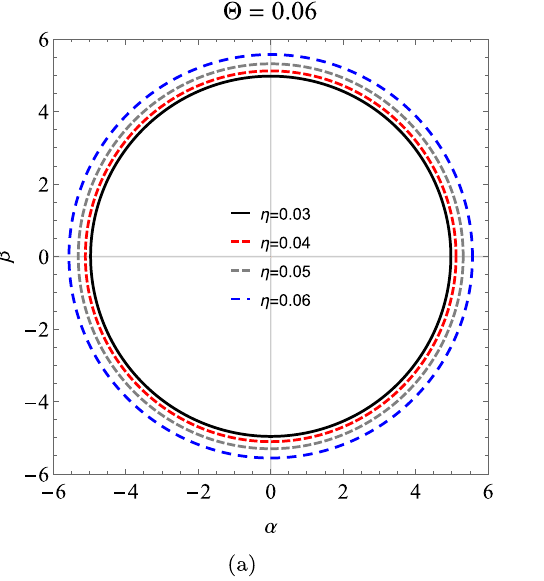
Fig. 10 Influence of the (cid:11) and η parameters on the shadow